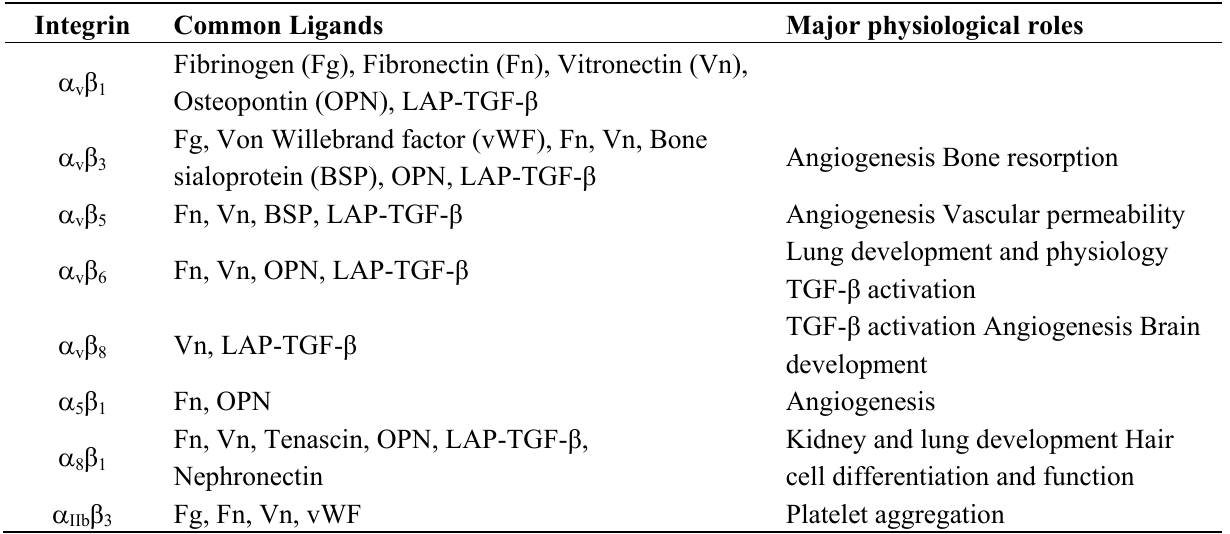
Table 1. RGD-binding integrins